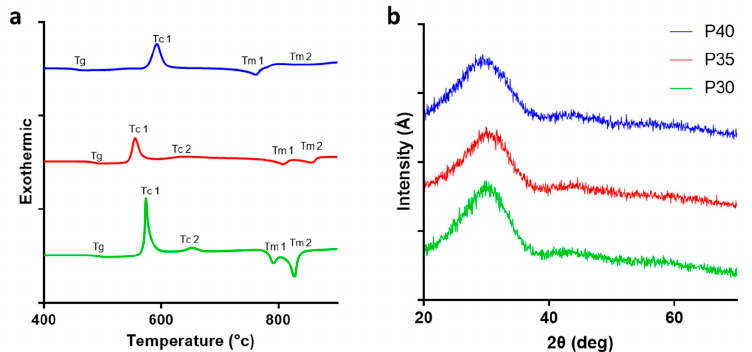
Figure 1. Glass characterization of P40, P35, and P30. ( a ) Thermal analysis traces via differential scanning calorimeter (DSC) of the phosphate-based glasses (PBG) formulations showing Tg, Tc, and Tm. ( b ) XRD spectra confirming the amorphous nature of P40, P35, and P30 glasses produced. Table 2. Glass transition (T g ), onset of crystallisation (T c ), melting temperature (T m ), and calculated thermal processing window (Tc onset ) for P40, P35, and P30.